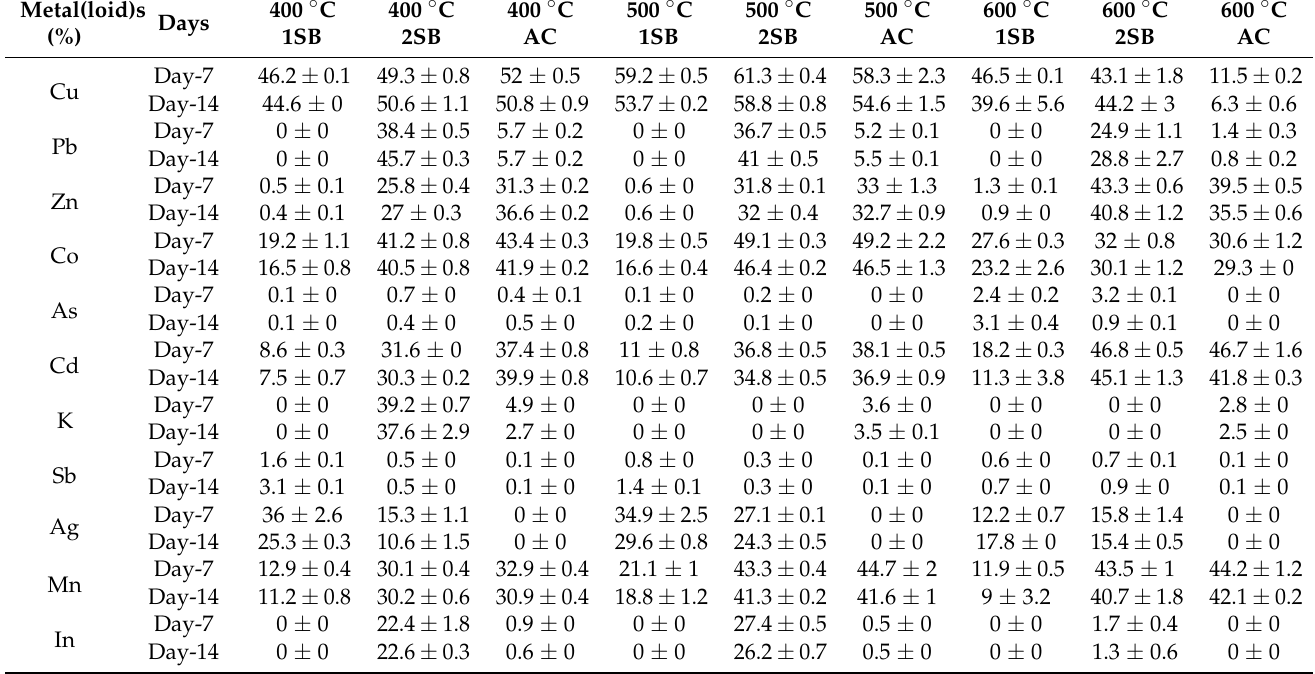
Table A9. Percentages of the metal(loid)s extracted from the microwave-roasted (at 400, 500 and 600 ◦ C) Neves Corvo waste rock (NC_01) by T. electrotropha via one-step bioleaching (1SB), two-step bioleaching (2SB) and the abiotic control (AC). Values are the average of duplicate flasks ± standard